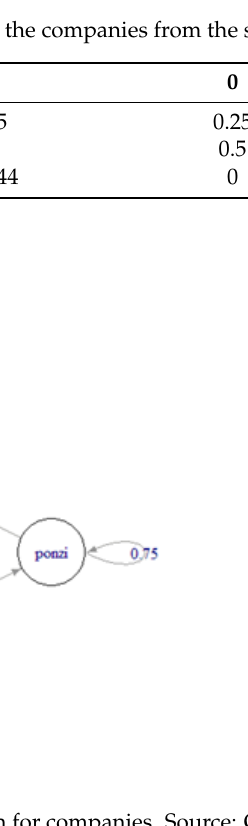
Figure 3. Matrix of graphical transition for companies. Source: Own elaboration with R-project and igraph package.